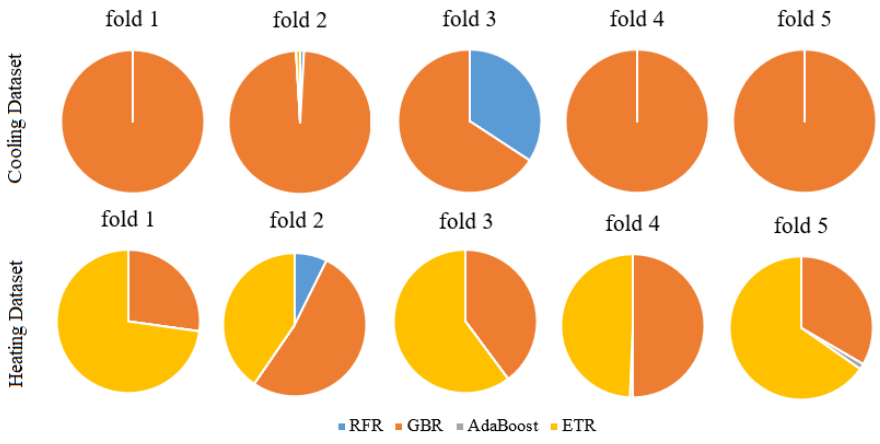
Figure 12. PTA Ensemble Weights Summary.